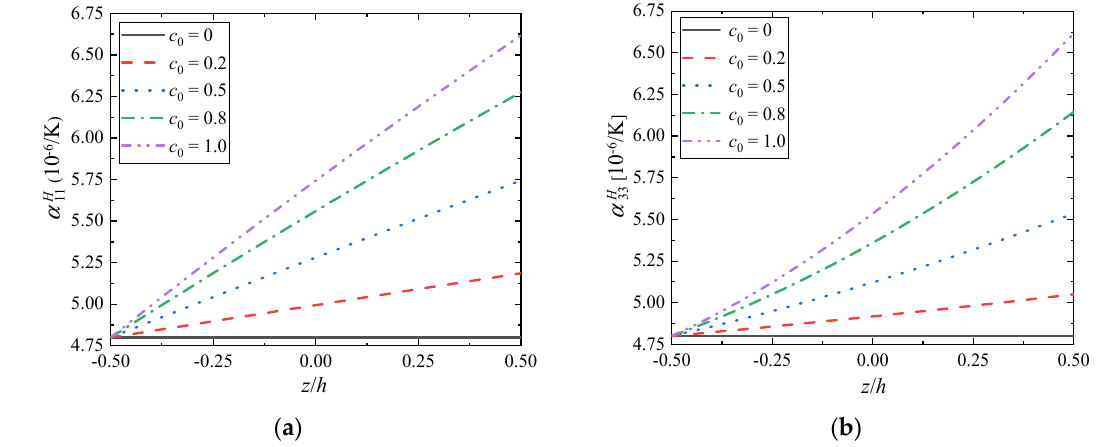
H and ( b ) 𝛼 H along the gradient direction ( m = 1.0). and ( b ) α H along the gradient direction ( m = 1.0). Figure 8. Distributions of ( a ) 𝛼 11 H and ( b ) 𝛼 33 H along the gradient direction ( m = 1.0). 11 33 33 11